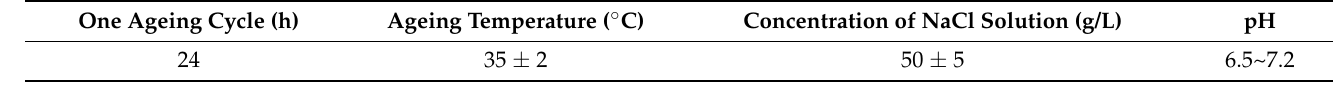
Table 1. Salt mist ageing conditions.